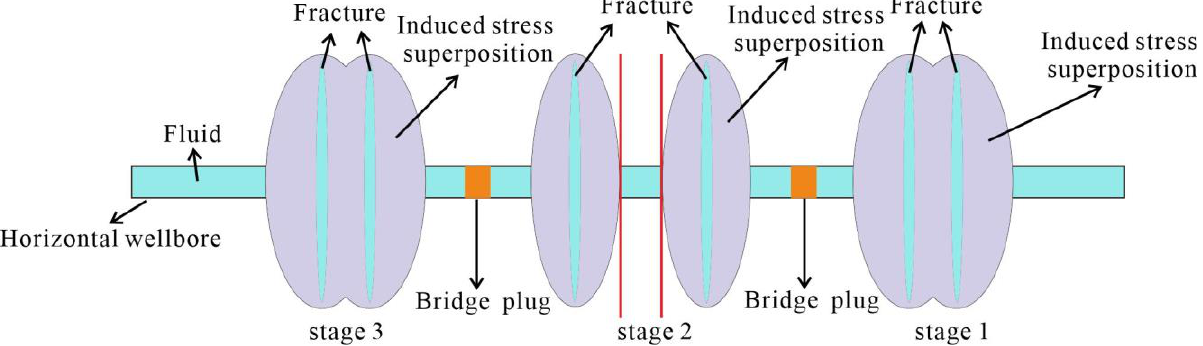
Figure 8. Influence of stress shadow effect caused by multi-stage fracturing in horizontal well on fracture propagation.